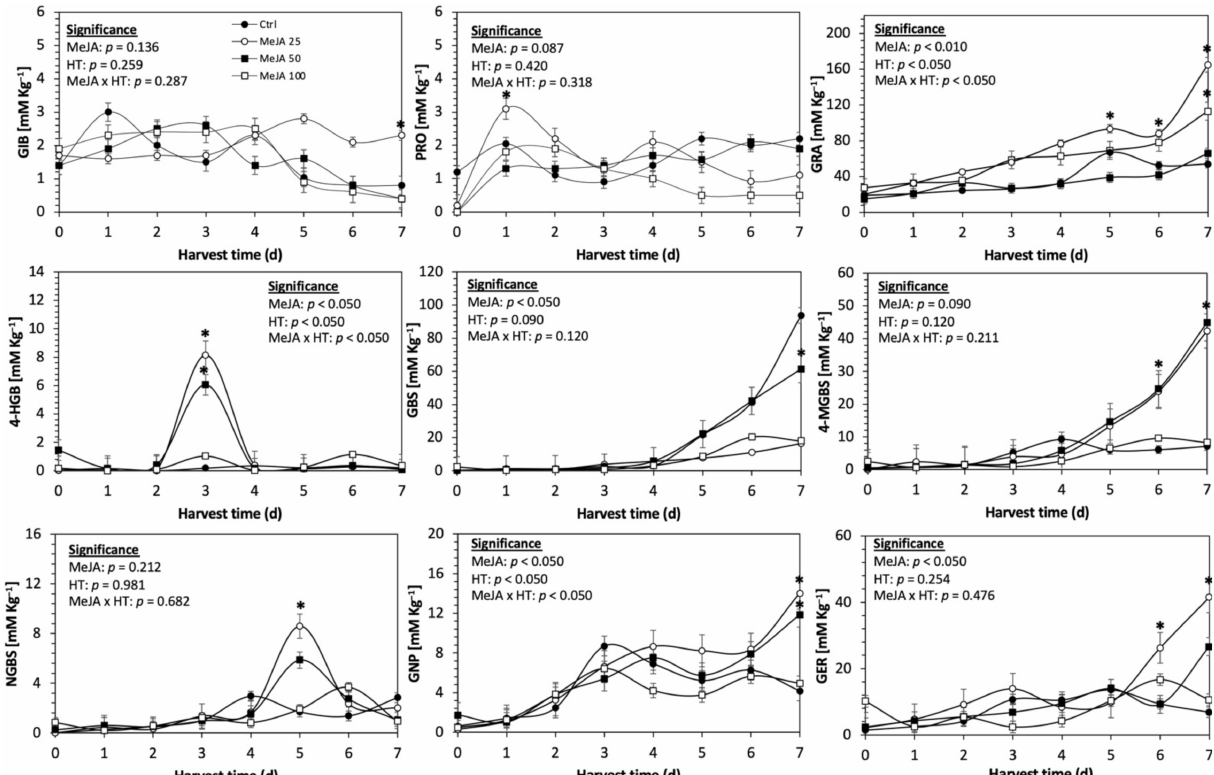
Figure 6. Concentration of individual glucosinolates in untreated Dwarf Green kale sprouts and treated with methyl jasmonate during the first 7 days of germination. Bars are means of 3 replicates ± standard error. Data points with an asterisk (*) indicate statistical difference determined by a t -test ( p < 0.050) between the control and treated samples. Abbreviations: methyl jasmonate (MeJA), harvest time (HT), glucoiberin (GIB), progoitrin (PRO), glucoraphanin (GRA), 4-hydroxy-glucobrassicin (4- HGB), glucobrassicin (GBS), 4-methoxy-glucobrassicin (4-MGBS), glucoeurocin (GER), gluconapin (GNP), and neoglucobrassicin (NGBS). Results are expressed as desulfogucoraphanin equivalents in dry weight